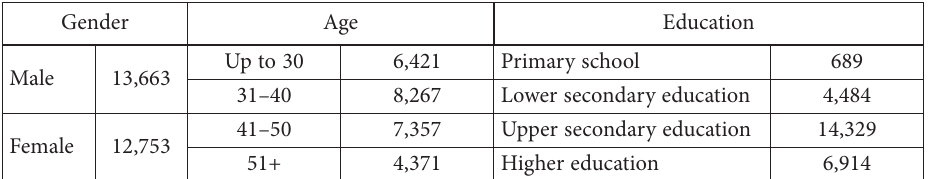
Table 2. Structure of sampling